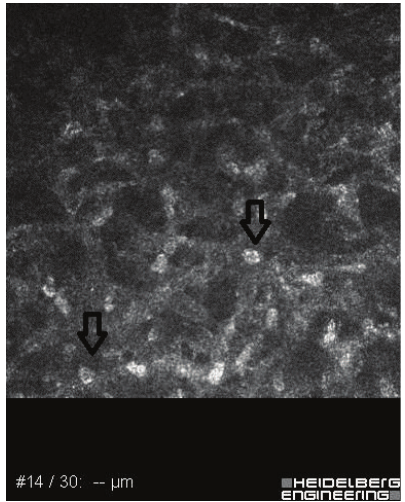
Figure 2: Confocal corneal examination revealing double-walled acanthamoebal cysts.